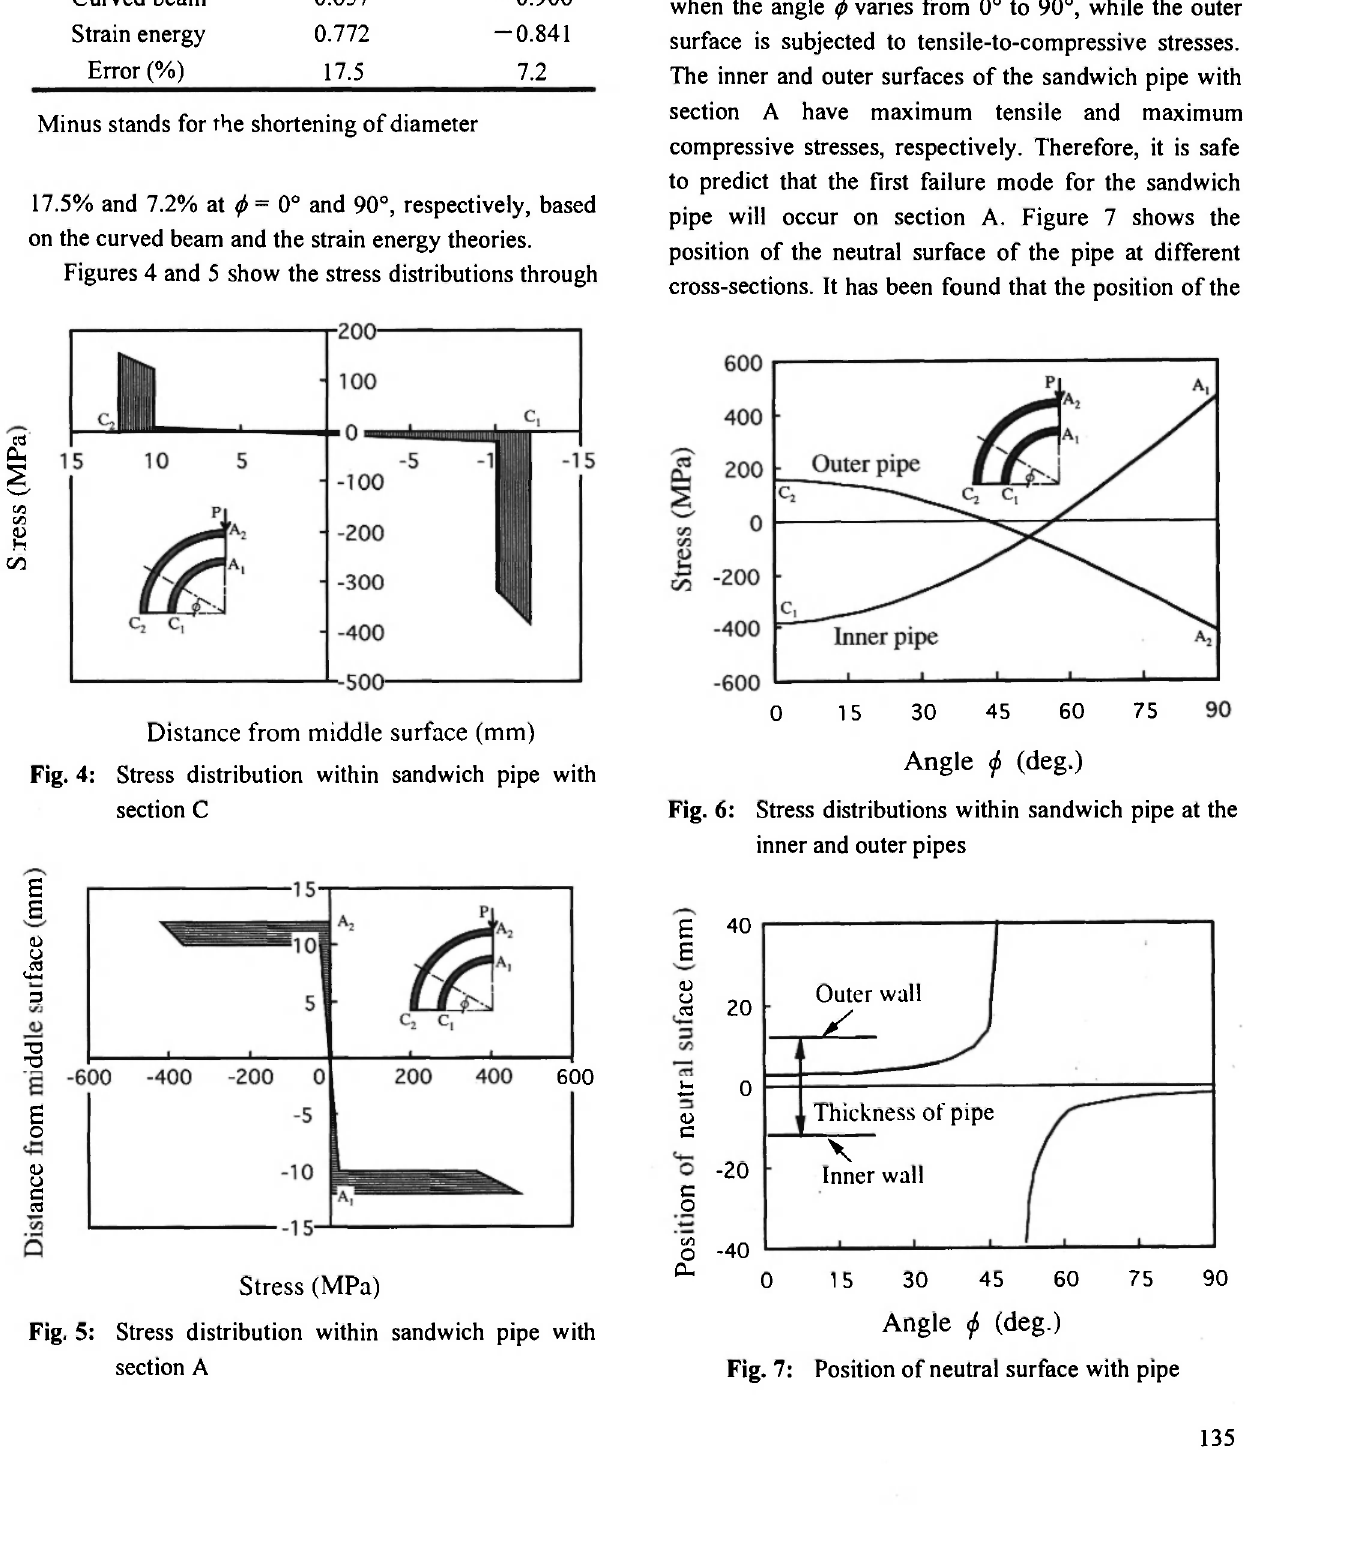
Stress (MPa) Fig. 5: Stress distribution within sandwich pipe with section A